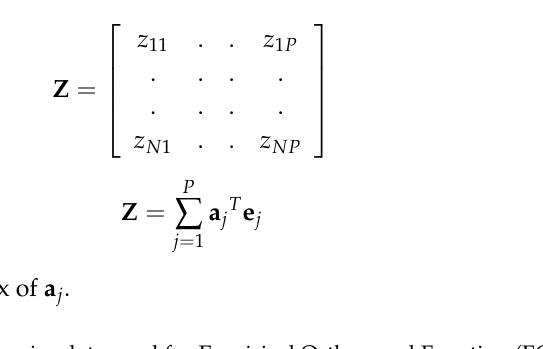
Table 4. Description of time series data used for Empirical Orthogonal Function (EOF) analysis.